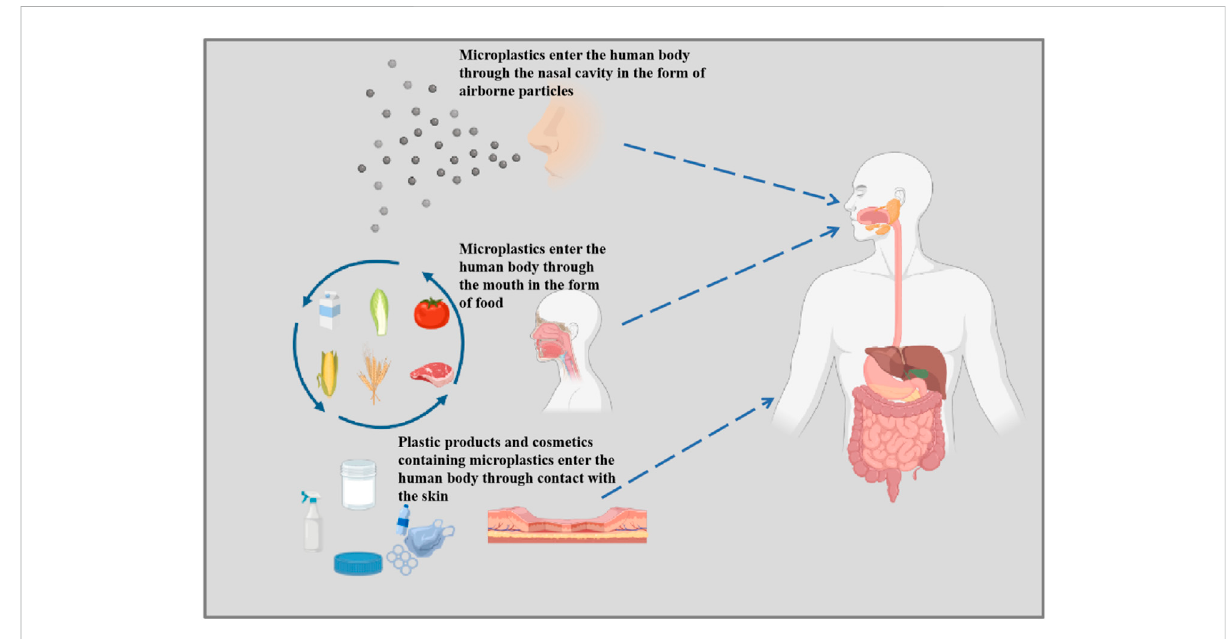
FIGURE 7 The main route for microplastics to enter the human